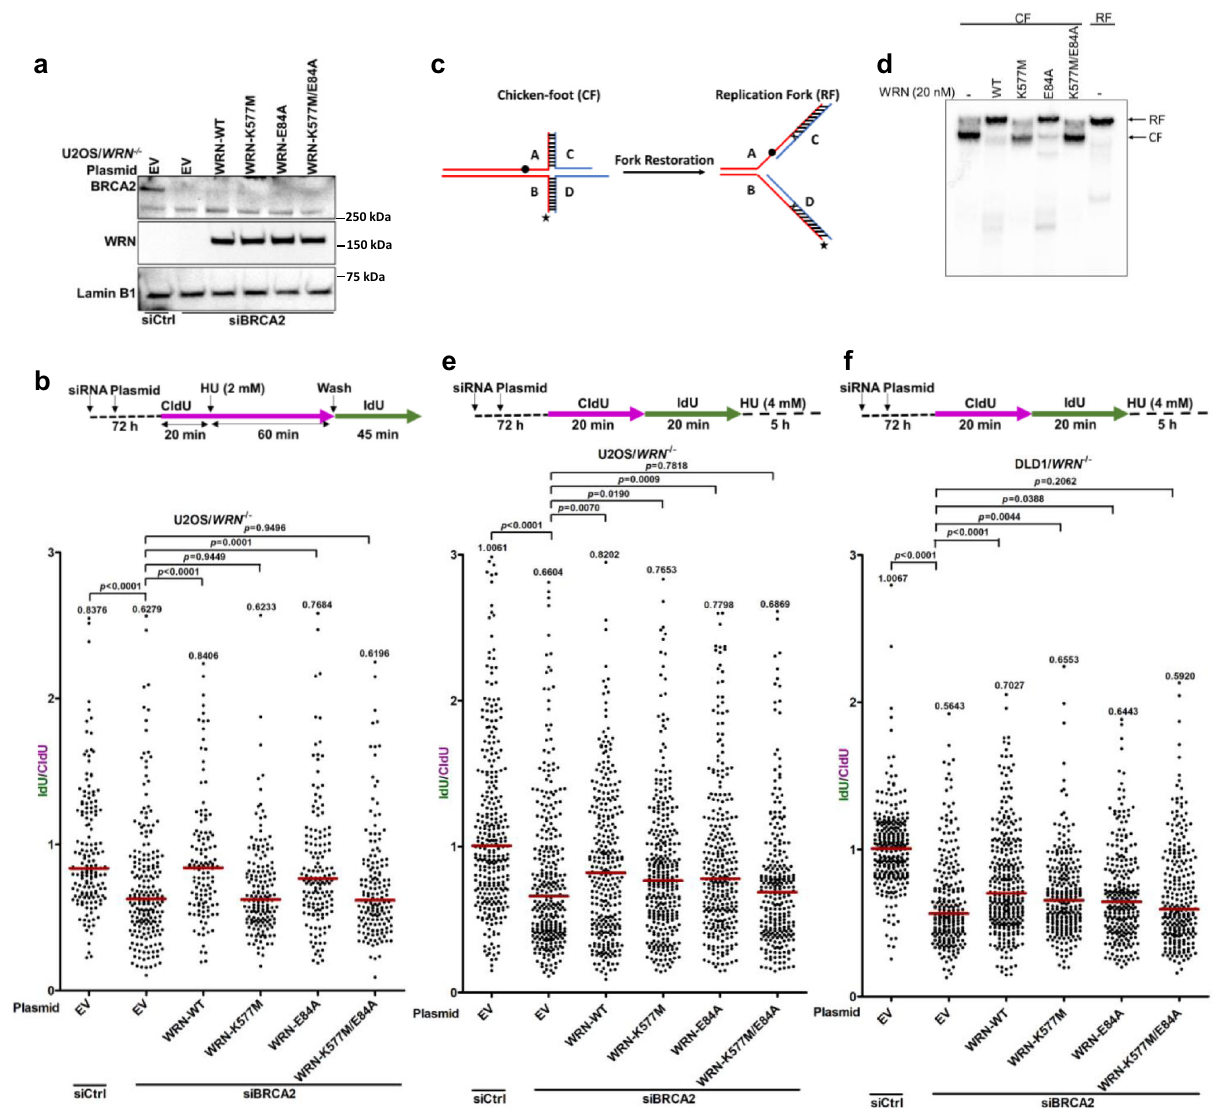
Fig. 1 WRN helicase rescues fork restart defects and restrains hyper-degradation of stalled forks in BRCA2-de fi cient cells. a Immunoblots showing BRCA2 and WRN protein levels in BRCA2-depleted U2OS/ WRN − / − cells transfected with the indicated plasmids. b Fork restart assay in BRCA2-depleted U2OS/ WRN − / − cells complemented with WT or catalytic dead WRN. Scatter plot showing IdU/CldU ratios in individual experimental conditions. Representative of n = 2 independent experiments; p -values ( p < 0.0001, p < 0.0001, p = 0.9449, p = 0.0001, p = 0.9496) were derived from n ≥ 125 DNA fi bers usi n g two-tailed Mann – Whitney test. c Schematic of the in vitro fork restoration assay showing “ chicken-foot ” (CF) and replication fork (RF) structures. Star indicates radiolabeled ([ γ - 32 P] ATP) at 5´ DNA end. The black dot indicates the approximate position of an isocytosine base paired with a guanine on the opposite strand whereas the 2 X ’ s in the RF indicate mismatched bases. Both modi fi cations serve to minimize spontaneous conversion of the CF to the RF structure. d WRN ATPase/helicase activity catalyzes replication fork restoration in vitro. Fork restoration assay with 2 nM CF DNA substrate was performed using 20 nM of WT or catalytic mutant WRN proteins (lanes 2-5). Reactions using CF (lane 1) and RF (lane 6) substrates without WRN were used as negative and positive controls, respectively. Experiment was repeated three ( n = 3) times with similar results. e , Quanti fi cation of fork stability assay performed in cells as described in a. Representative of n = 3 independent experiments; p -values ( p < 0.0001, p = 0.0070, p = 0.0190, p = 0.0009, p = 0.7818) were derived from n ≥ 250 DNA fi bers using two-tailed Mann – Whitney test. f , Quanti fi cation of fork stability assay performed in BRCA2-depleted DLD1/ WRN − / − cells upon complementation with WT or catalytic dead WRN. Representative of n = 2 independent experiments; p -values ( p < 0.0001, p < 0.0001, p = 0.0044, p = 0.0388, p = 0.2062) were derived from n ≥ 230 DNA fi bers using two-tailed Mann – Whitney test. In b , e , and f , horizontal red bars indicate median of IdU / CldU ratios; median IdU/CldU values are indicated; purple and green colors indicate CldU and IdU labeling, respectively; data points within the speci fi ed axis limits are shown. Lamin B1 was used as loading control in immunoblots. Western blots ( a ) were repeated independently at least two times with similar results. Source data are provided as a Source Data fi exonuclease on the substrate (Supplementary Fig. 1b). Digestion of the reversed fork DNA substrate by MRE11 was found to be substantially reduced in the presence of WRN-E84A, suggesting WRN helicase activity curtails MRE11-mediated fork degradation in vitro.